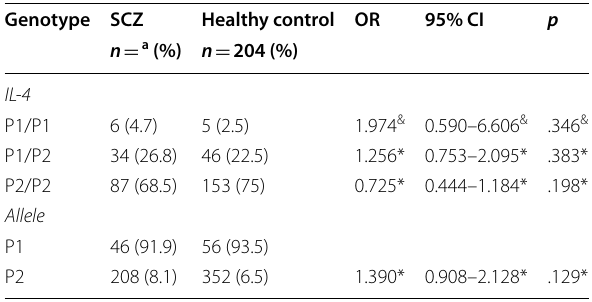
Table 4 Comparison of frequencies of the IL-4 VNTR polymorphism between SCZ patients and healthy controls